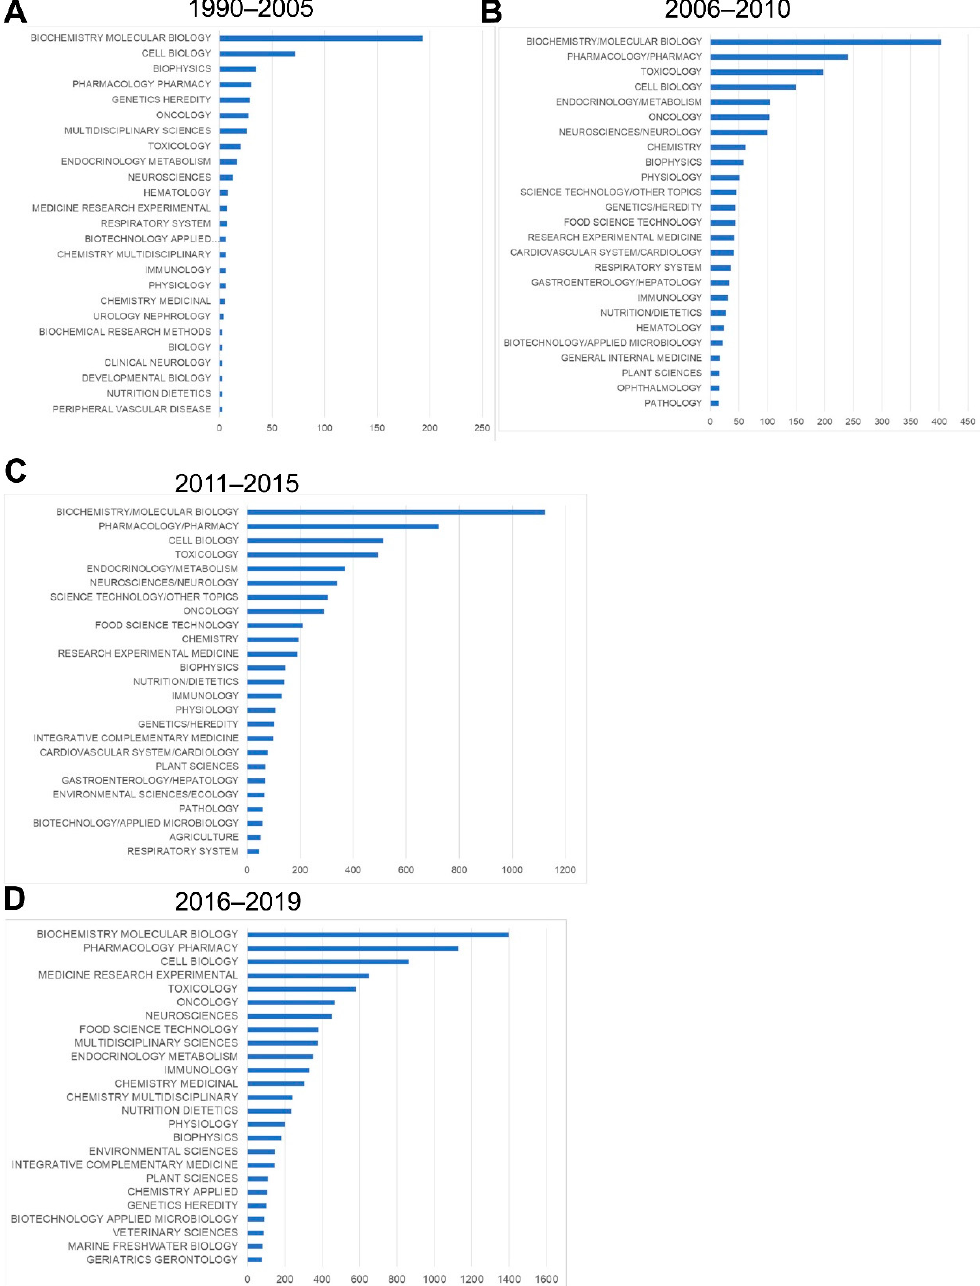
Figure 6. Top 25 research areas of Nrf2-related studies per indicated time period. ( A ) 1990–2005. ( B ) 2006–2010. ( C ) 2011–2015. ( D ) 2016–2019. Data up to July 2019. Each bar indicates the number of Nrf2-related papers falling into the respective research area. Each paper can belong to more than one research